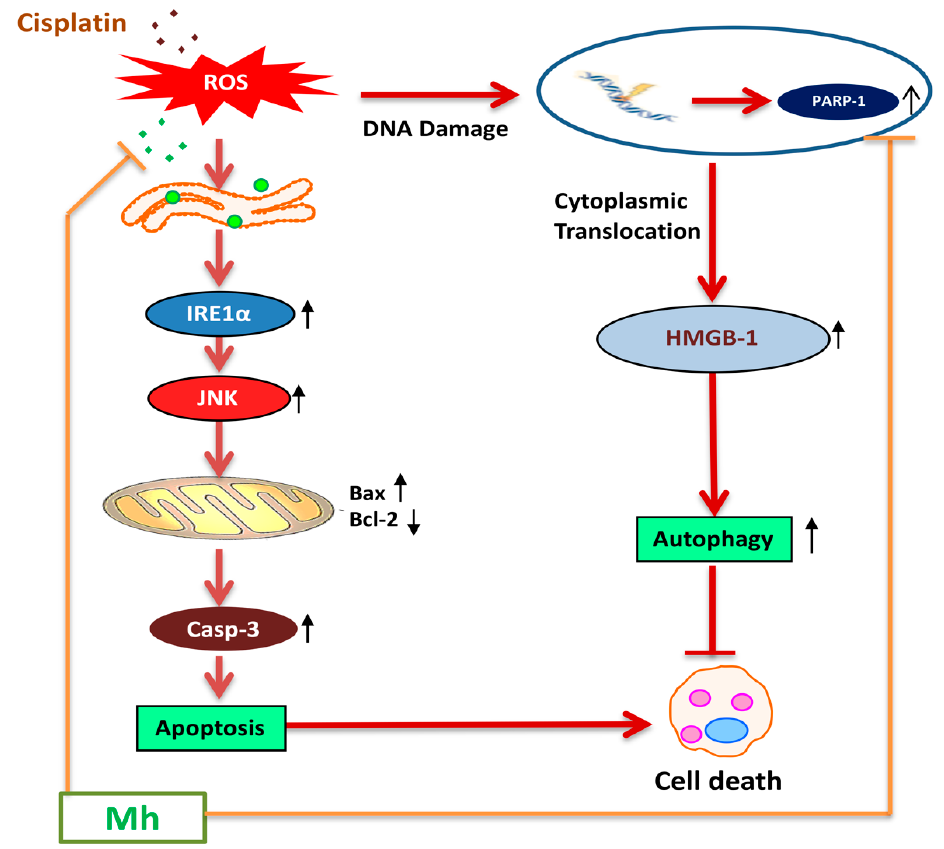
Figure 11. Schematic representation of mechanisms of CP-Mh regulated apoptosis and autophagic in vitro and in vivo. Cisplatin induced PARP-1 leads to HMGB1 mediated autophagy activation and consequently inhibited apoptosis. Combination of CP-Mh reduced autophagy activation via regulating ROS generation and PARP-1 expression and sensitized HCC cells towards JNK-mediated apoptotic cell death.